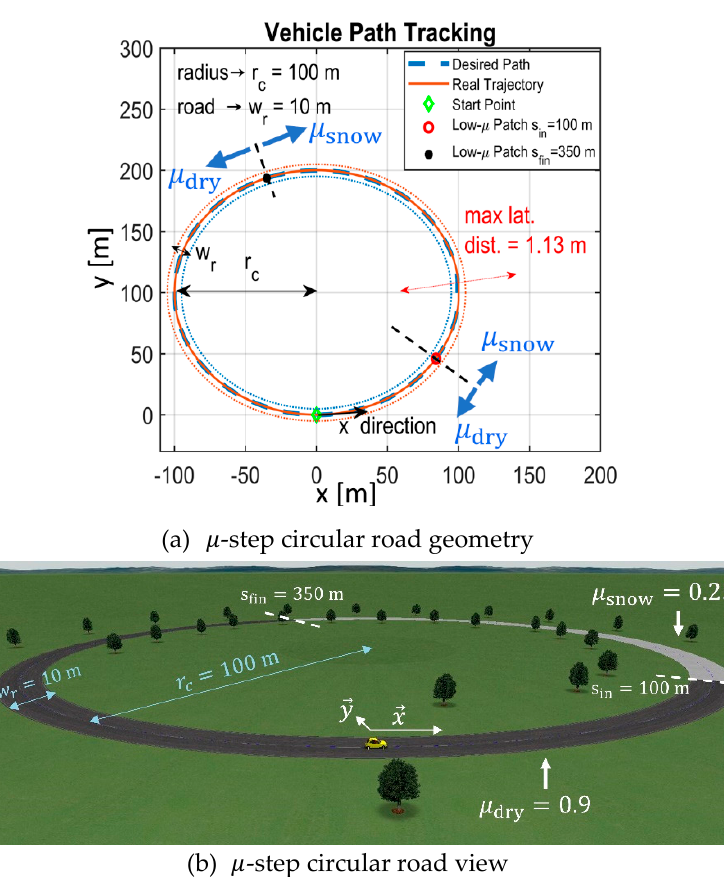
Figure 20. Bending on Low-Friction Patch: 100[m] radius circular with 𝜇 -varying.